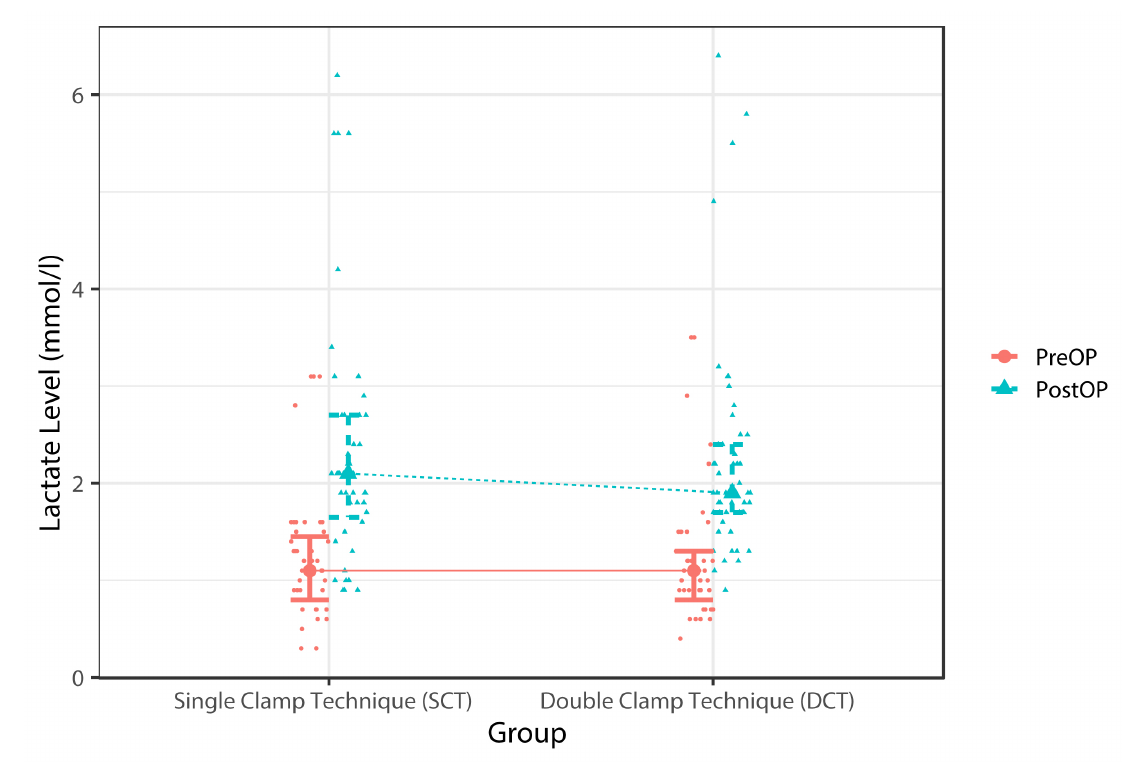
Fig. 1 - Whisker plot showing preoperative (5 minutes before cross-clamping) and postoperative (10 minutes after CPB) mean blood lactate levels in the DCT and SCT